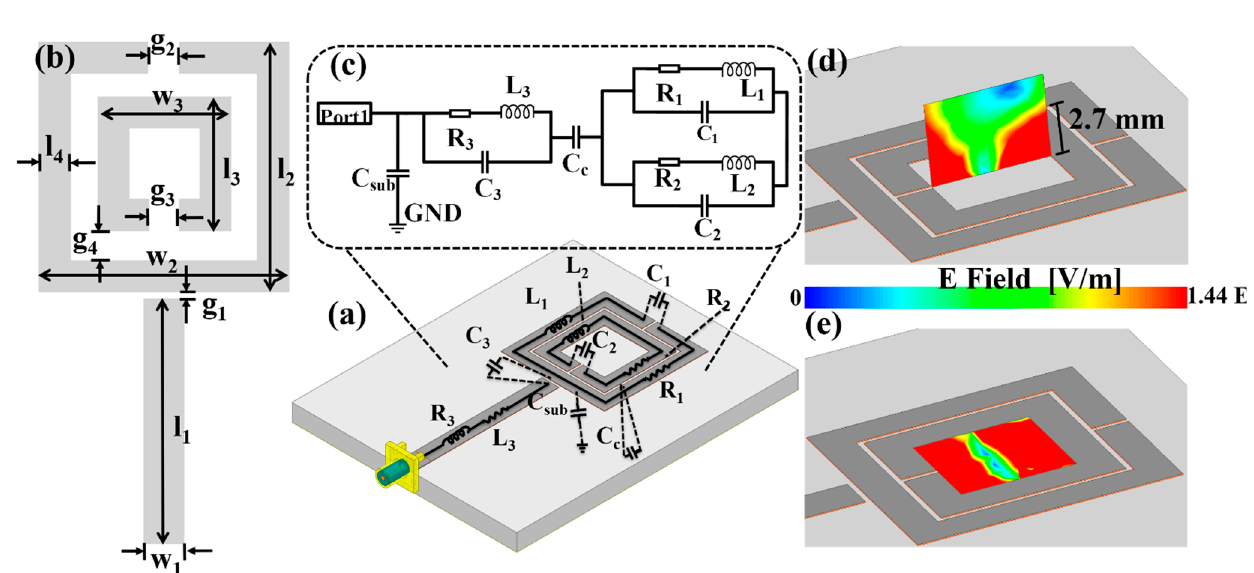
Figure 1. ( a ) Structure and size of the proposed Reader, ( b ) the equivalent circuit of the proposed split-ring structure, ( c ) the proposed Reader structure model, ( d ) the electric field intensity distribution on the vertical, and ( e ) horizontal planes in the middle area of the Reader.